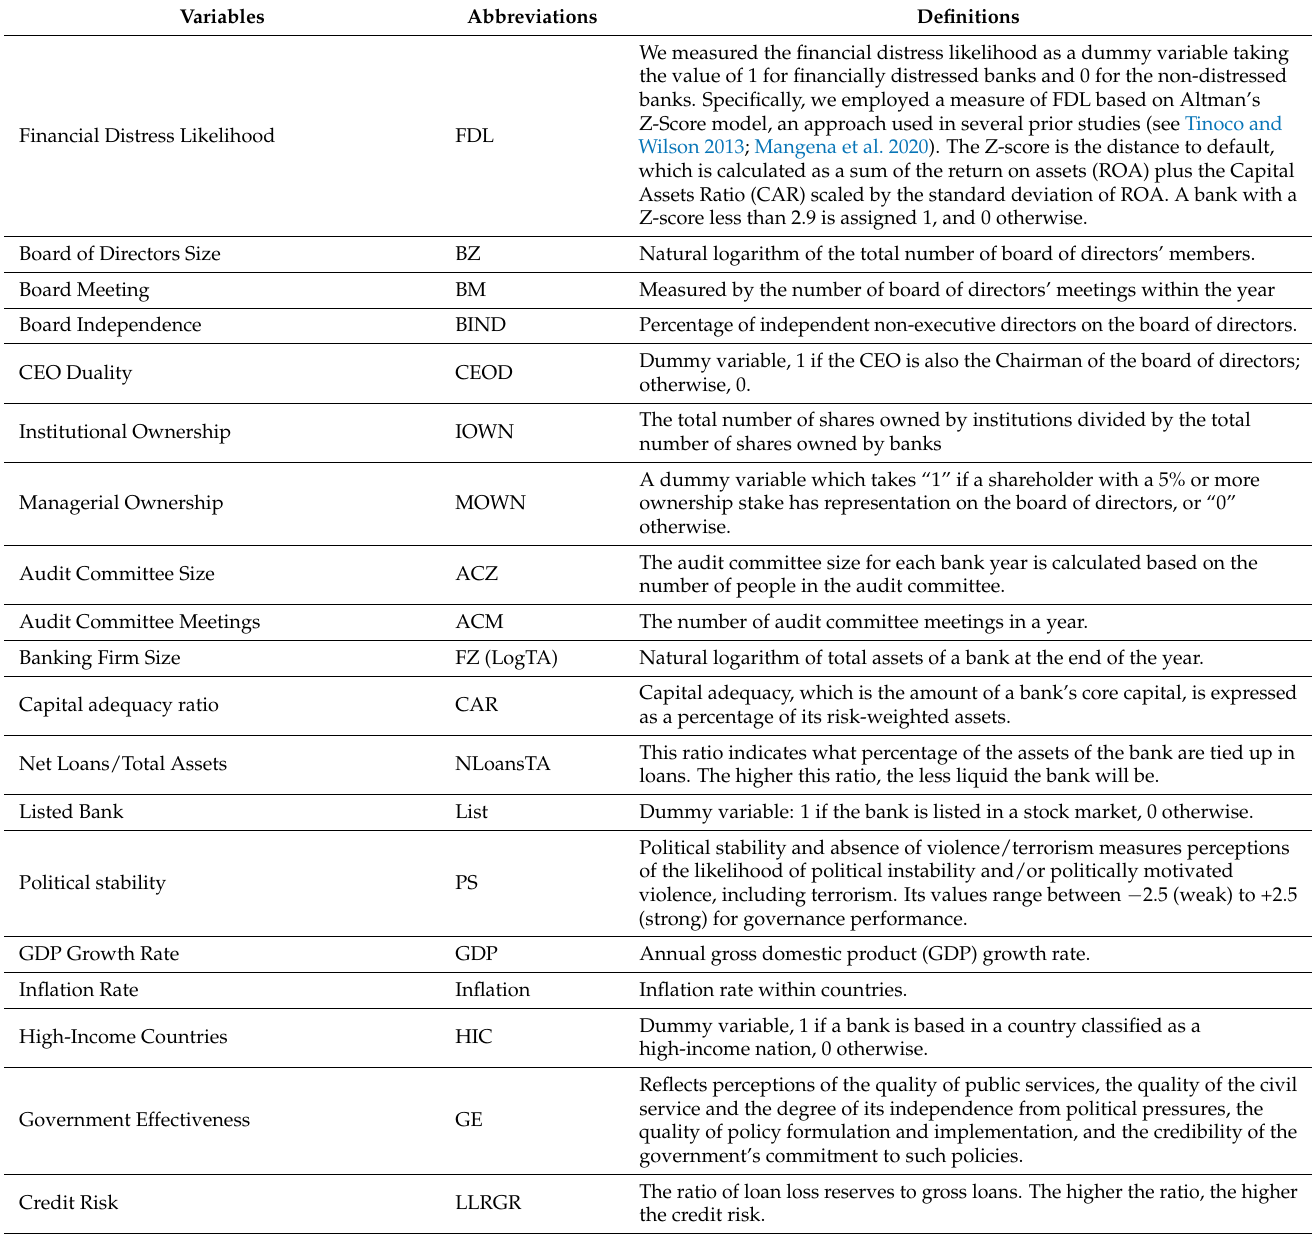
Table 2. The operational definition of research